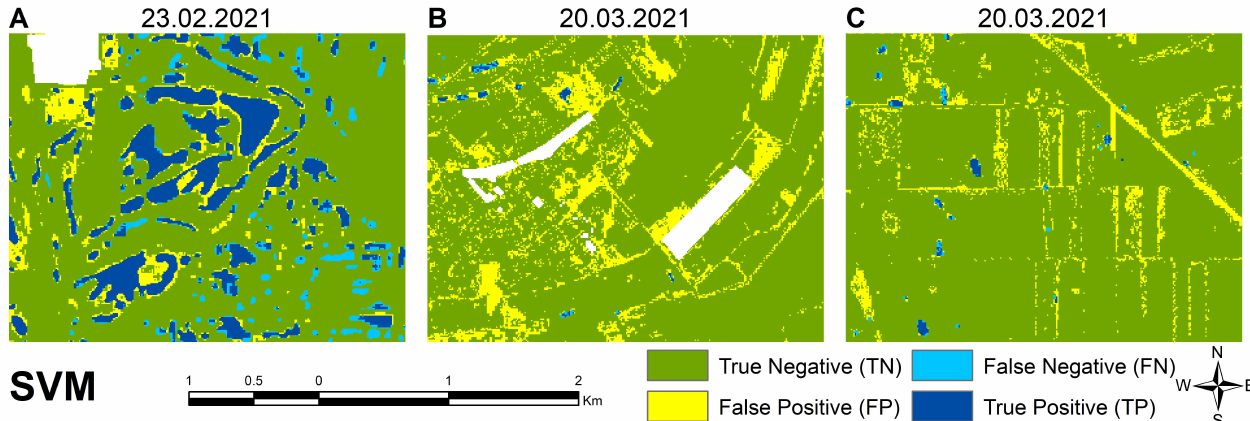
Figure 13. Examples of random forest model classification errors at different times, including ( A ): Relatively small omissions 23 February 2021; ( B ): extreme overclassification in general 20 March 2021; and ( C ): Extreme overclassification around the cloud and shadow mask 20 March 2021.